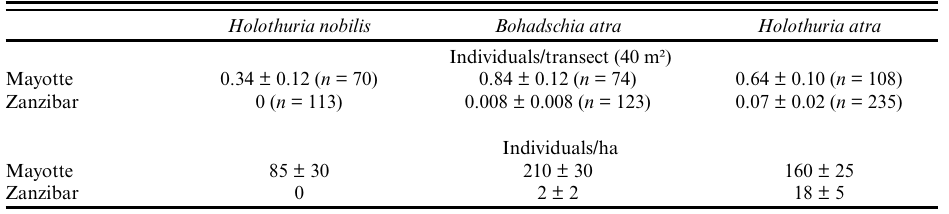
Table 2 . Abundance of target species, showing mean values ± standard error of individuals/transect and calculated per ha. Mean values are calculated for transects defined as having suitable habitat for each individual species based on substrate composition. Bohadschia atra Holothuria atra